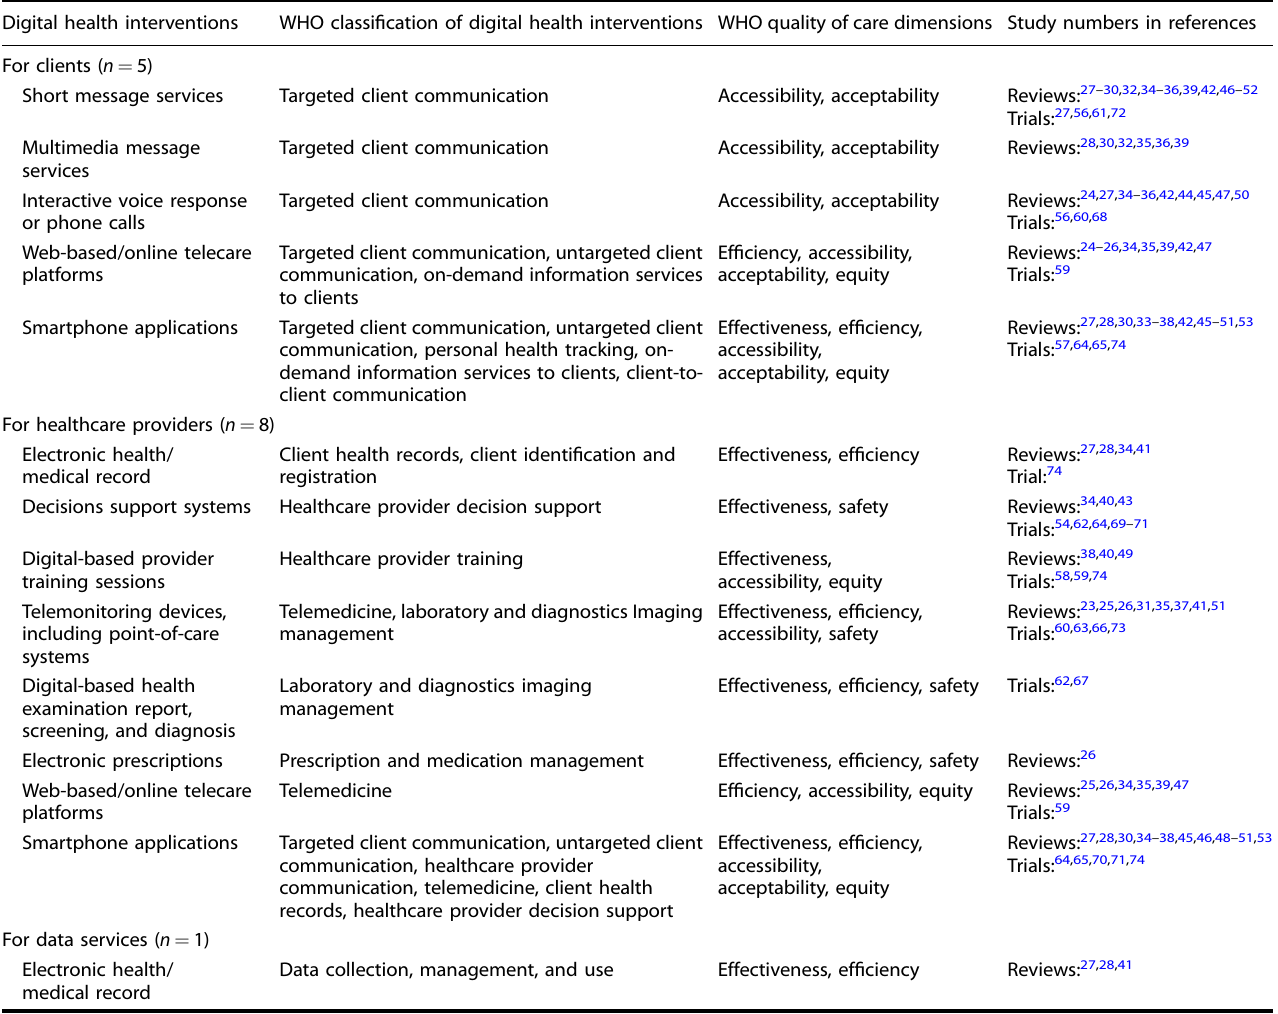
Table 1. Identi fi ed digital health interventions for non-communicable disease management in primary health care. Digital health interventions For clients ( n =